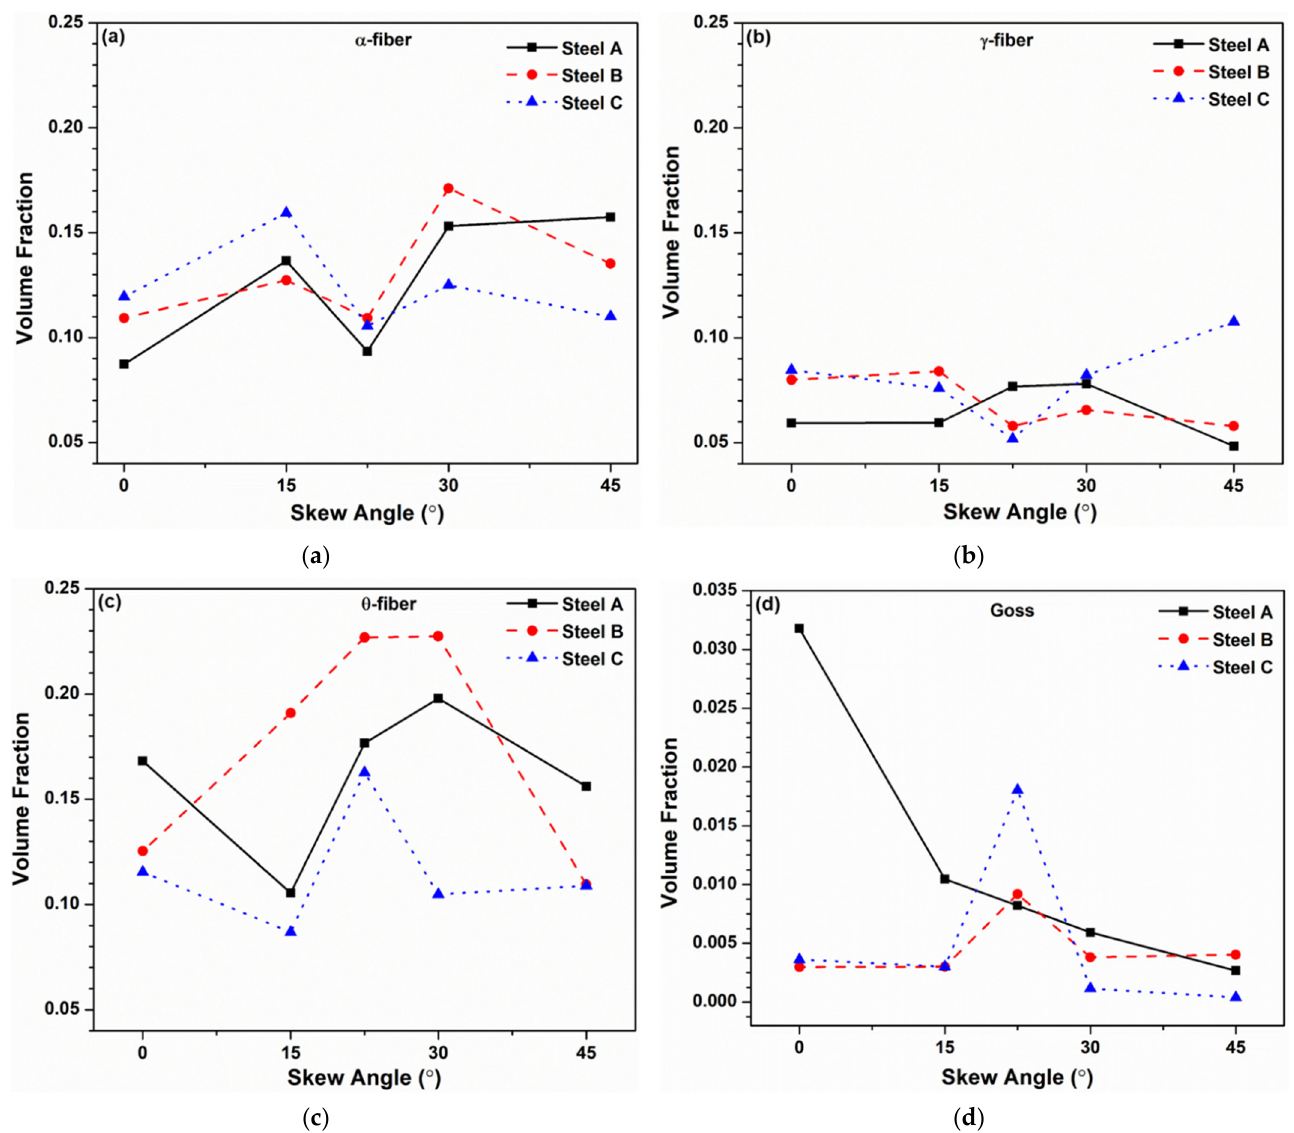
Figure 11. Variations of the volume fractions of common texture fibers, ( a ) α -fiber, ( b ) γ -fiber, ( c ) θ - fiber and the Goss component ( d ), after skew cold rolling and annealing (bidirectional feeding).